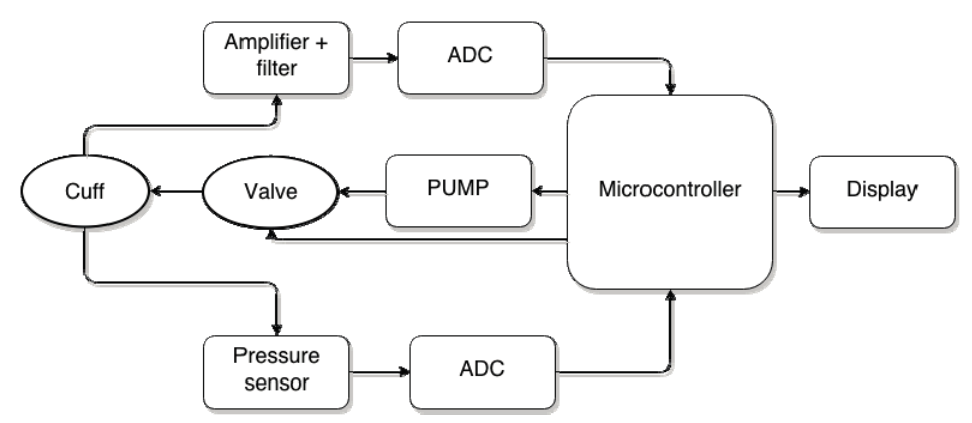
Figure 2. System operation